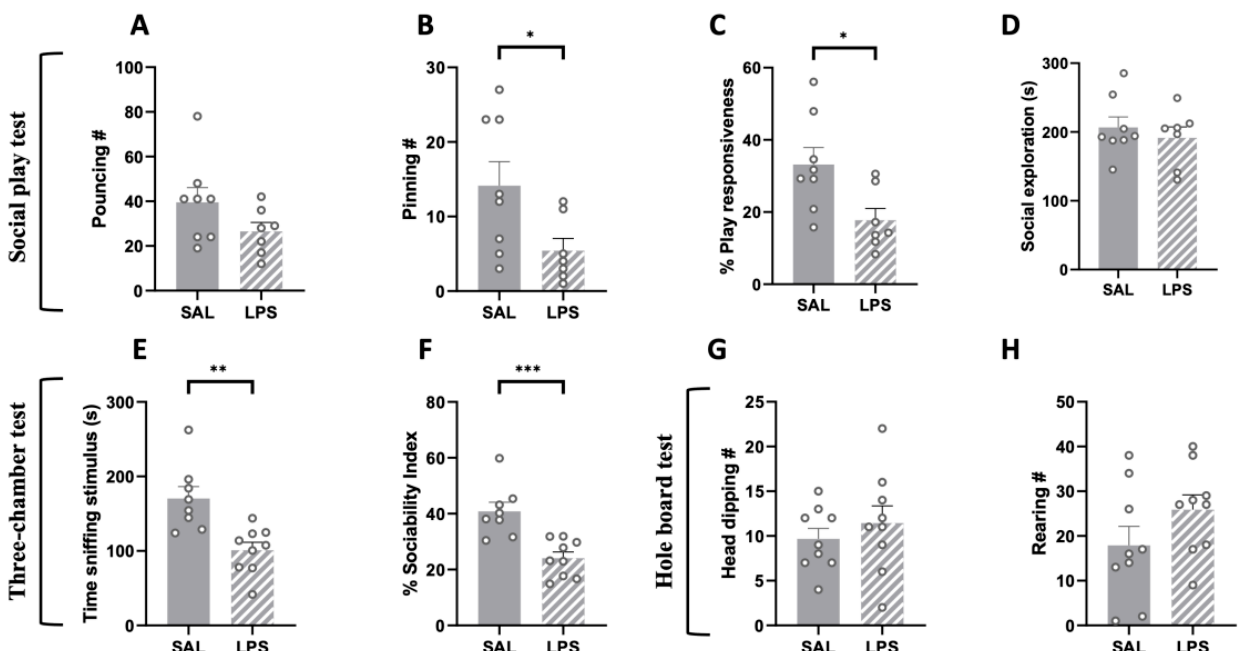
Figure 2. Effects of prenatal LPS exposure in the social play, three-chamber and hole board tests in the adolescent rat offspring. Social play behavior was reduced in the adolescent offspring prenatally exposed to LPS ( A – C ), while general social exploration was unaffected ( D ) (SAL = 8, LPS = 7). LPS- exposed adolescent rats also showed reduced sociability in the three-chamber test, as they spent less time sniffing the stimulus animal ( E ) and showed a reduced sociability index ( F ) in this task (SAL = 8, LPS = 9). No differences between the two experimental groups were found in the hole board test (number of head dipping ( G ); rearing ( H )), indicating no stereotypic-like behaviors displayed by adolescent LPS-exposed rats in this task (PND 35: SAL = 9; LPS = 9). Data represent mean ± S.E.M. *